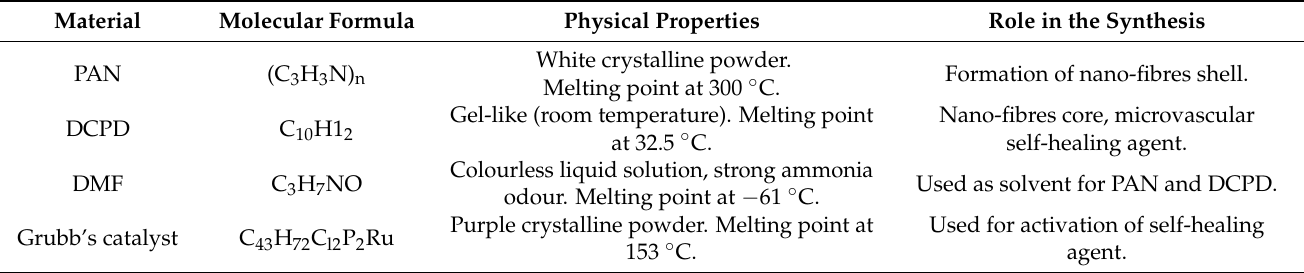
Table 1. Materials used for the microvascular network synthesis